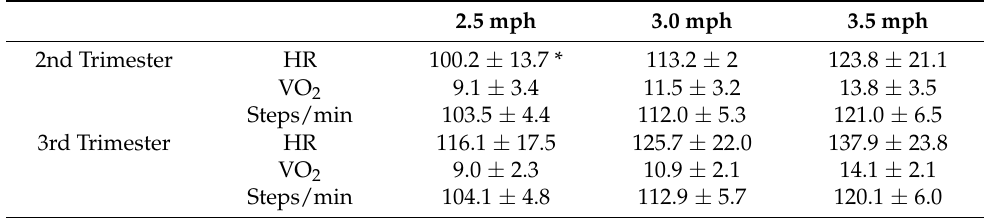
Table 1. Heart rate (HR), oxygen consumption (VO2), and cadence values in beats per minute, mL/kg*min, and steps/min, respectively, for 2nd- and 3rd-trimester pregnant women at three walking speeds.